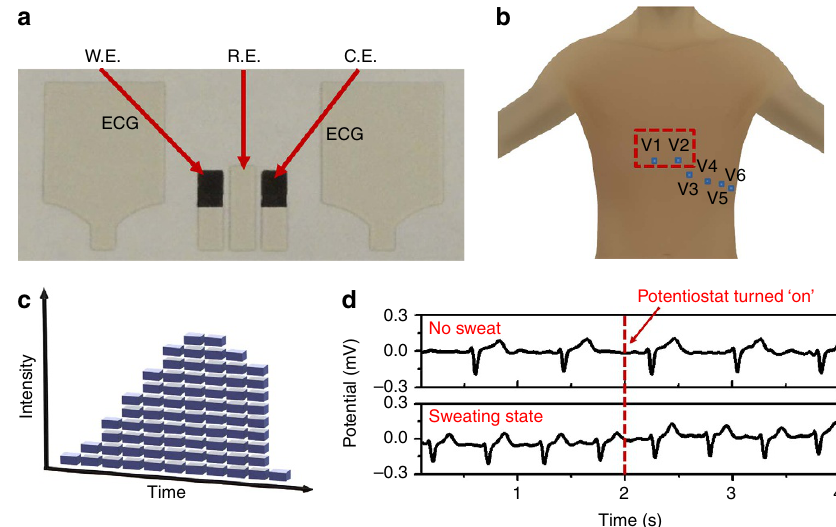
Figure 3 | On-body test configuration. ( a ) A photograph of Chem–Phys hybrid patch. ( b ) Location of the Chem–Phys patch for mounting on the human body—the fourth intercostal space of the chest. ( c ) Cycling resistance profile for on-body tests. ( d ) Effect of amperometric measurement on the electrocardiogram signal before cycling (no sweat state) and during cycling (sweating state).